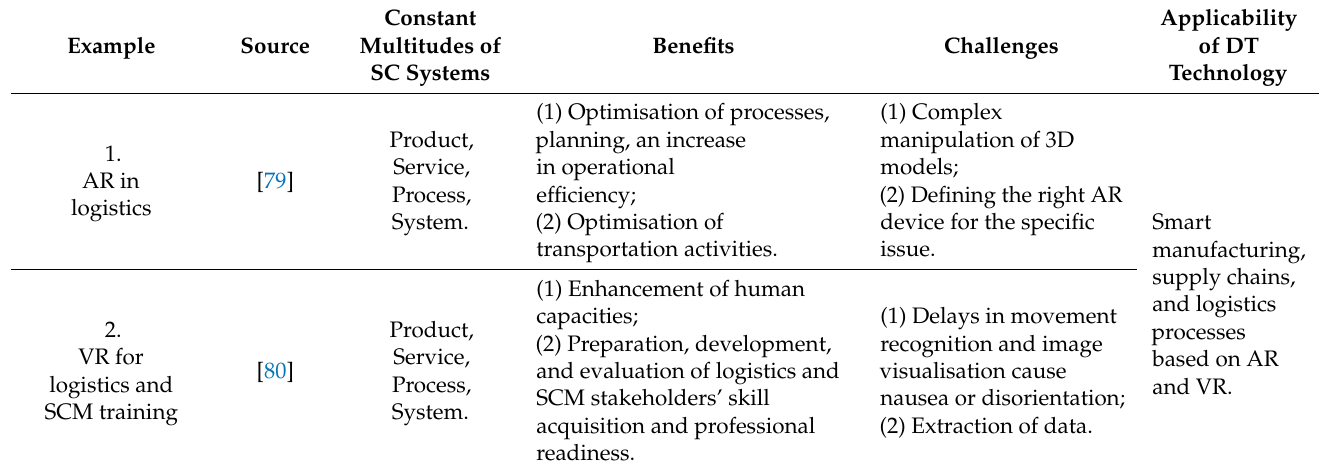
Table 2. Implementation examples of practical orientations and the applicability of Digital Twins through individual technology trends within supply